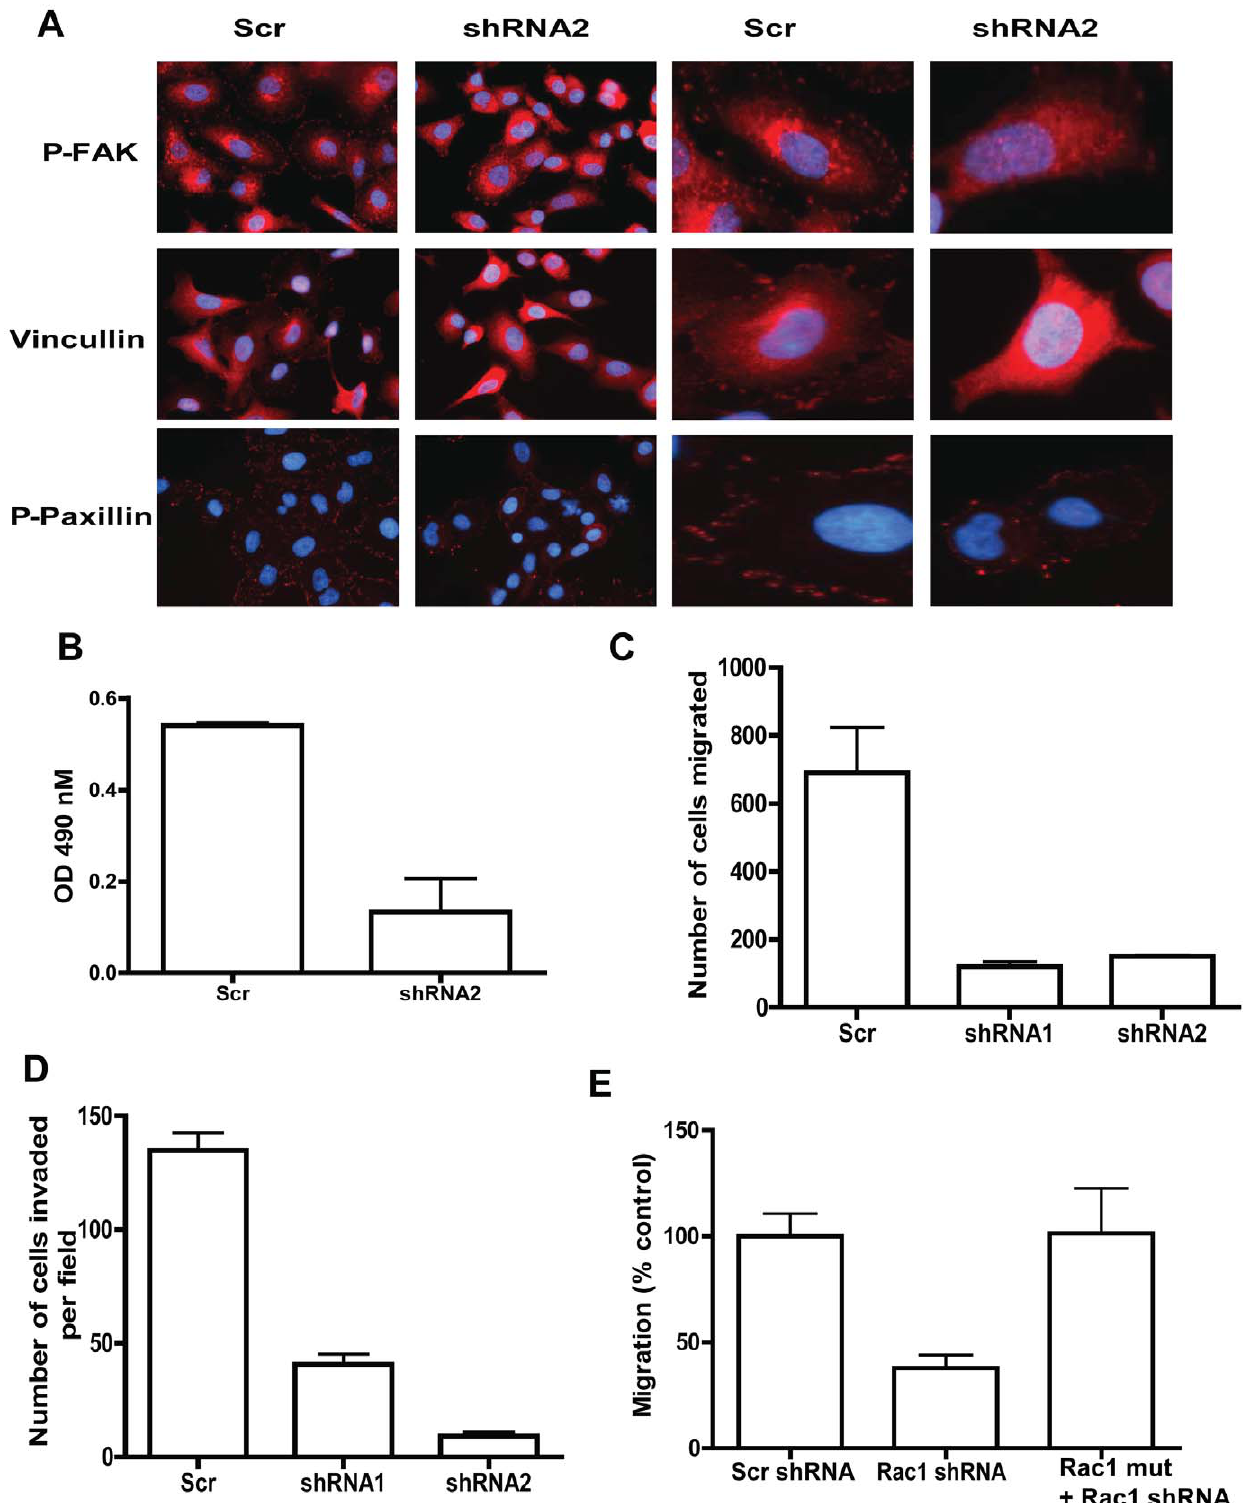
Figure 2. Targeting Rac1 blocks non-small cell lung cancer cell adhesion, migration and invasion. (A) Infected A549 cells were sorted, plated on fibronectin coated slides and stained with either p-FAK (top panel) or vinculin (middle panel) or p-Paxillin (lower panel) and DAPI. Images were collected using fluorescent microscope at 40X magnification. Images above are representative of several images obtained from two independent experiments. (B) A549 sorted cells were plated on fibronectin coated 96-well plate for in vitro adhesion assay and cells attached to plate after 1 hour was determined using MTS reagent. Adhesion assay was performed with five replicates and the data is representative of three independent experiments. (C) Sorted cells were plated on trans-well migration plates and migration of cells toward 10% FBS was measured